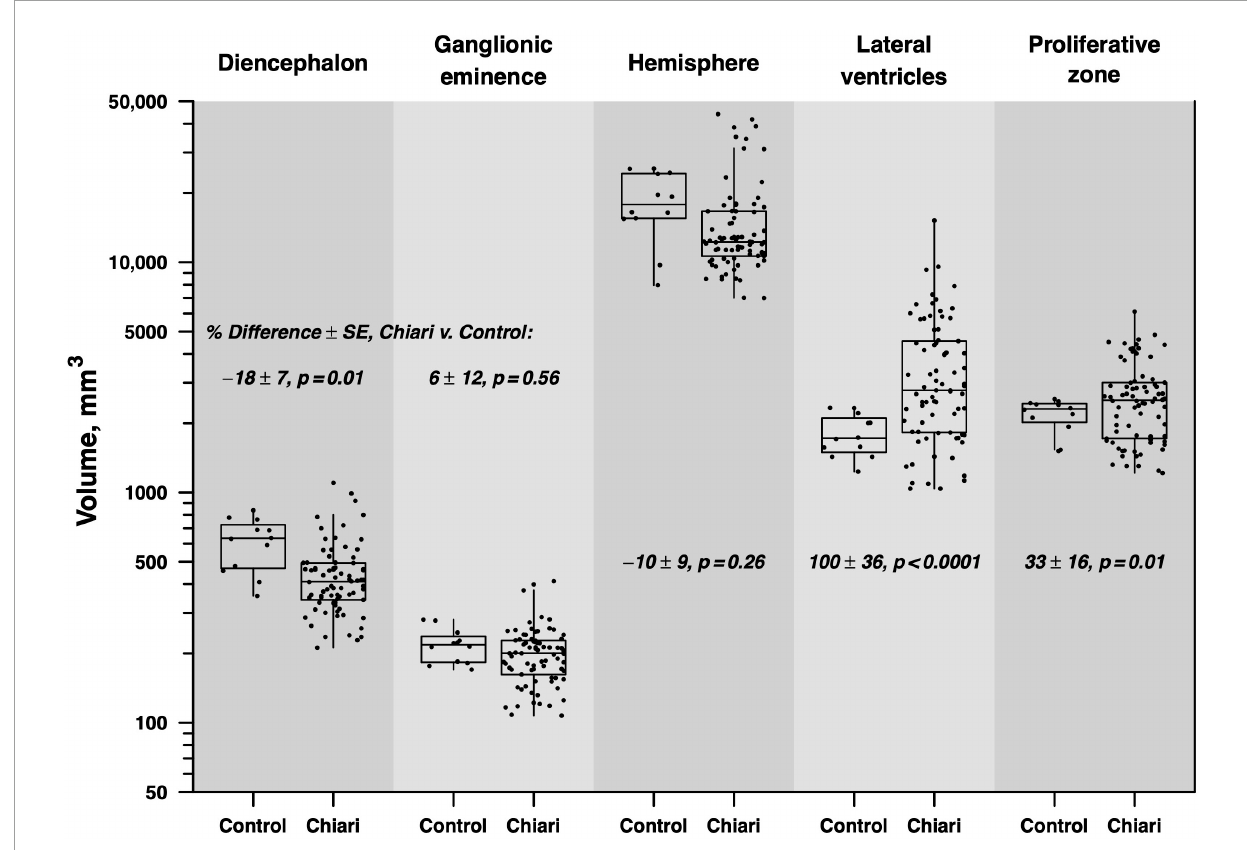
FIGURE1 Boxes indicate the median and interquartile range (IQR), with vertical lines extending to the last data point within a distance of 1.5 × IQR from the quartile boundary. The percentage difference between mean Chiari and control volumes is indicated with standard error and test of statistical significance, derived from repeated-measures regression analysis.